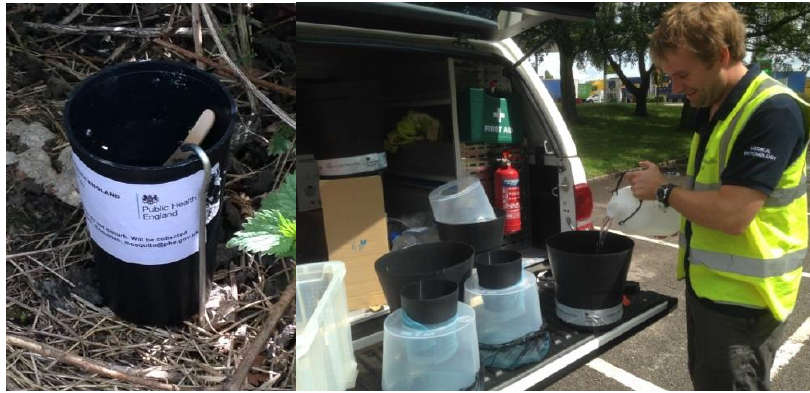
Figure 1. Invasive mosquito surveillance using ovitraps and Gravid Aedes traps at Ports of entry and transport hubs.